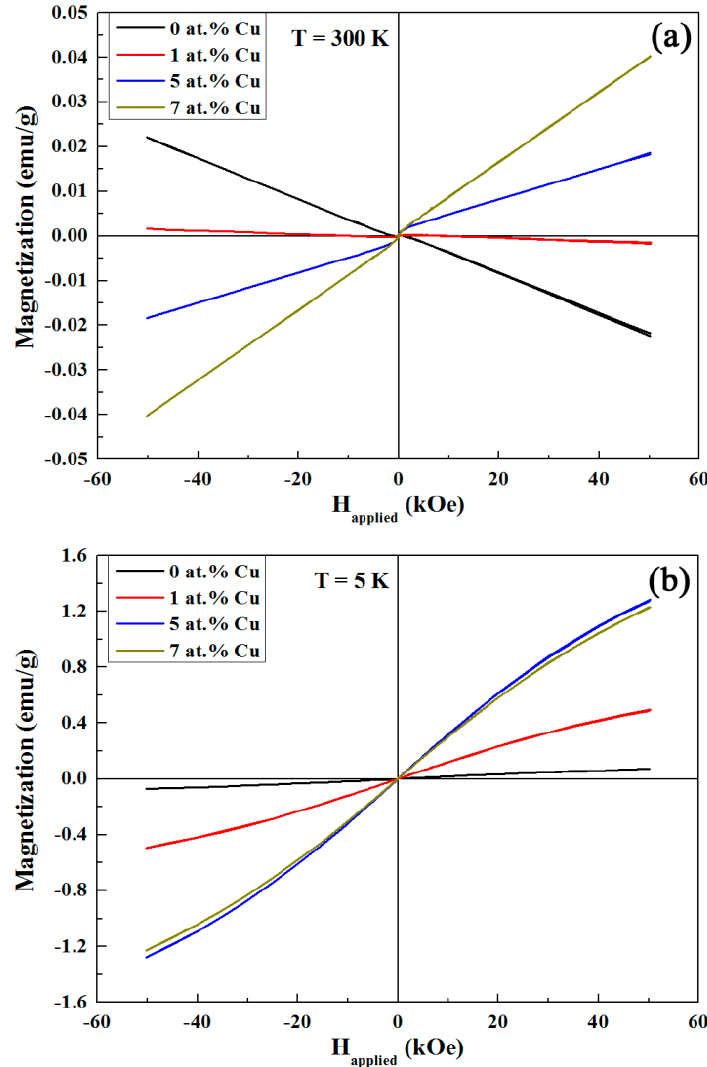
Figure 5. ( a ) Room temperature (300 K) and ( b ) 5 K SQUID measurements of the ordered mesoporous Cu-doped SnO 2 powders containing 0 (undoped), 1, 5, and 7 at.% Cu. The low temperature hysteresis loops were taken upon cooling from 300 K down to 5 K in an applied magnetic field of 50 kOe.